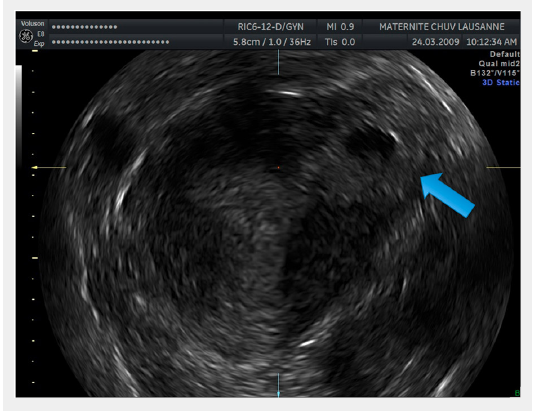
Image showing a left IP 3D reconstruction in a coronal sectional plane. The blue arrow indicates the lateral GS surrounded by a thin myometrial